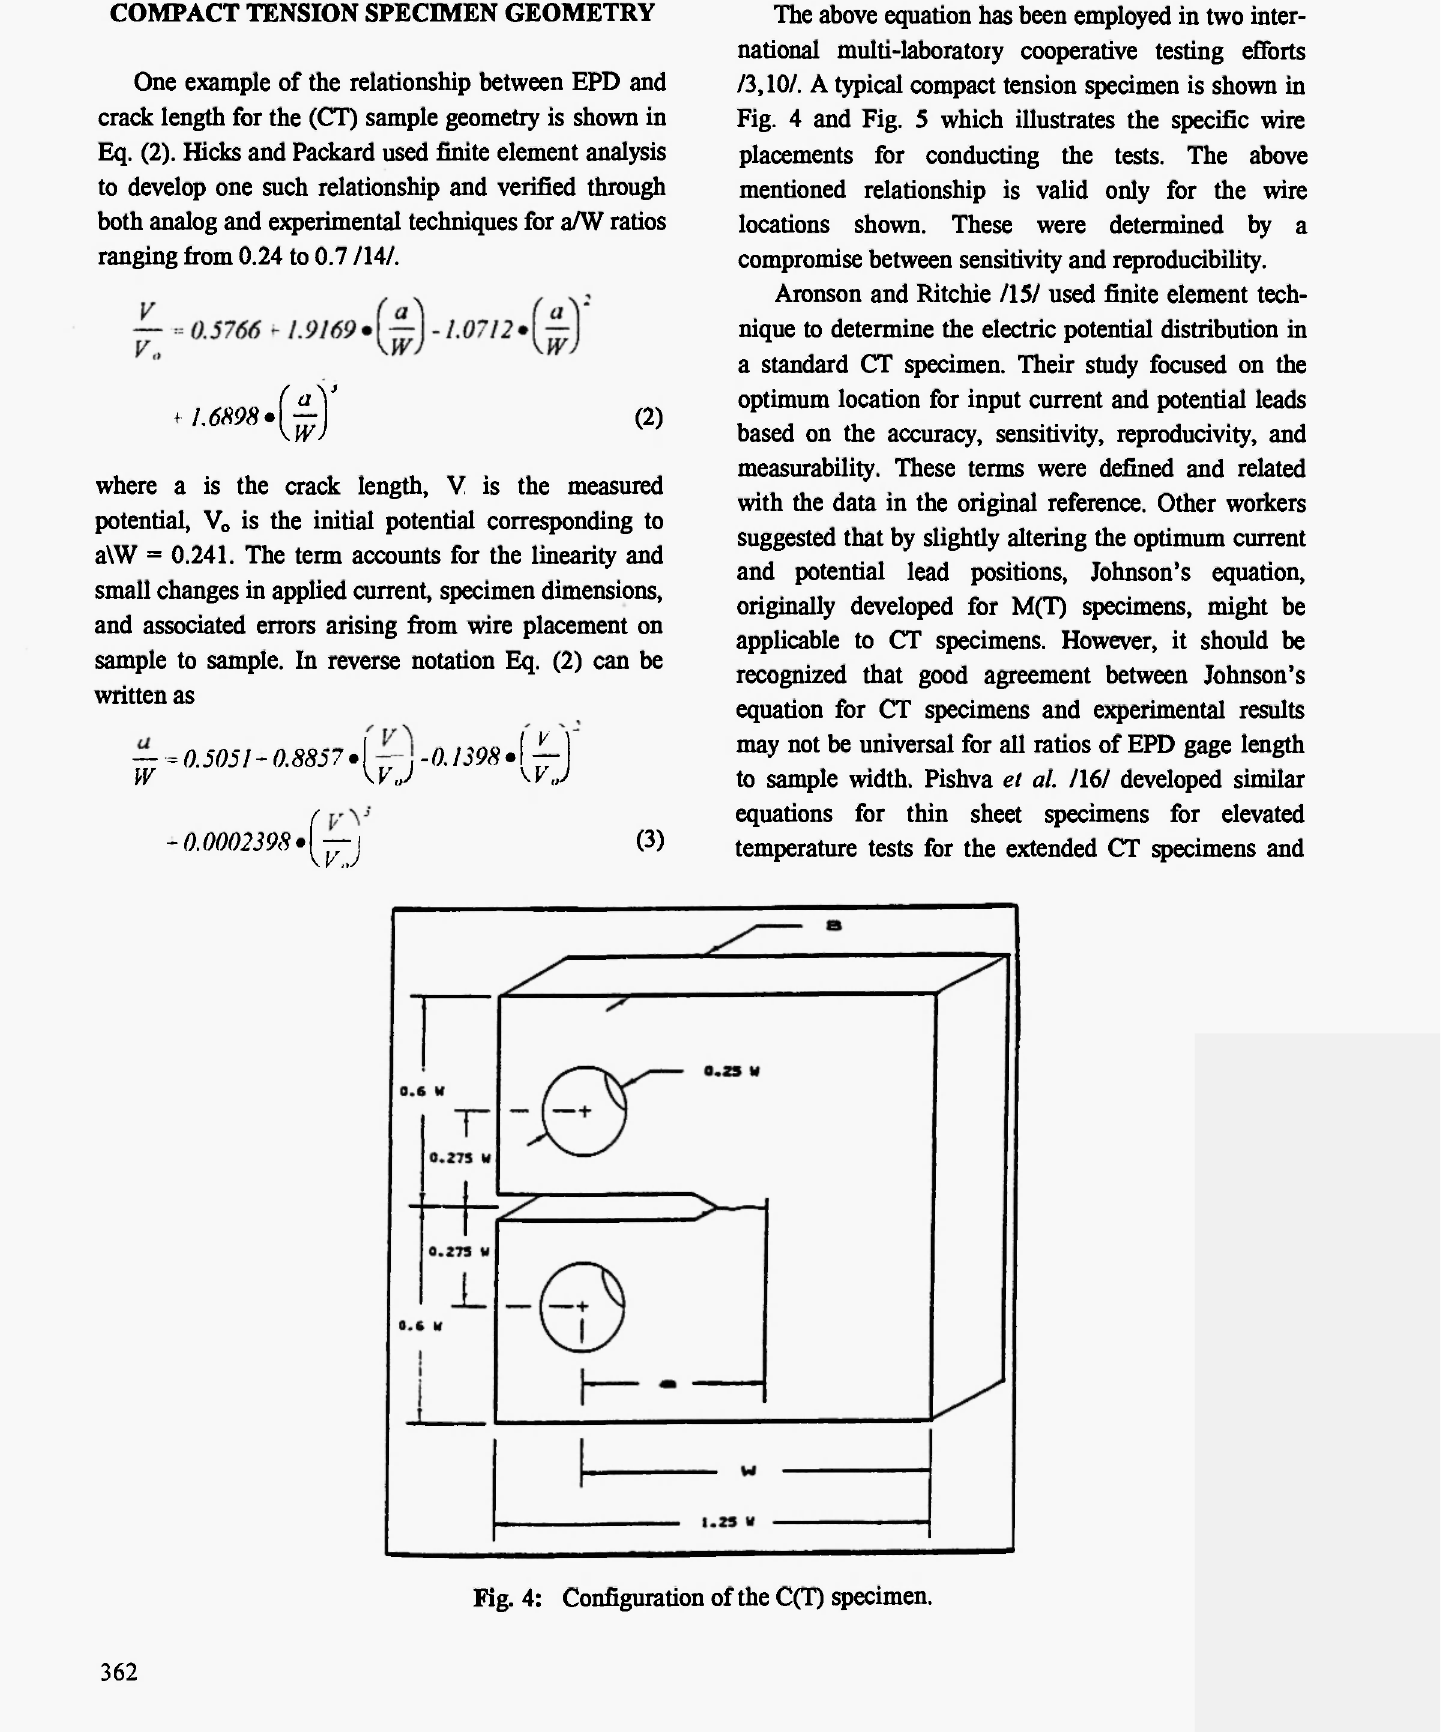
Fig. 4: Configuration of the C(T)